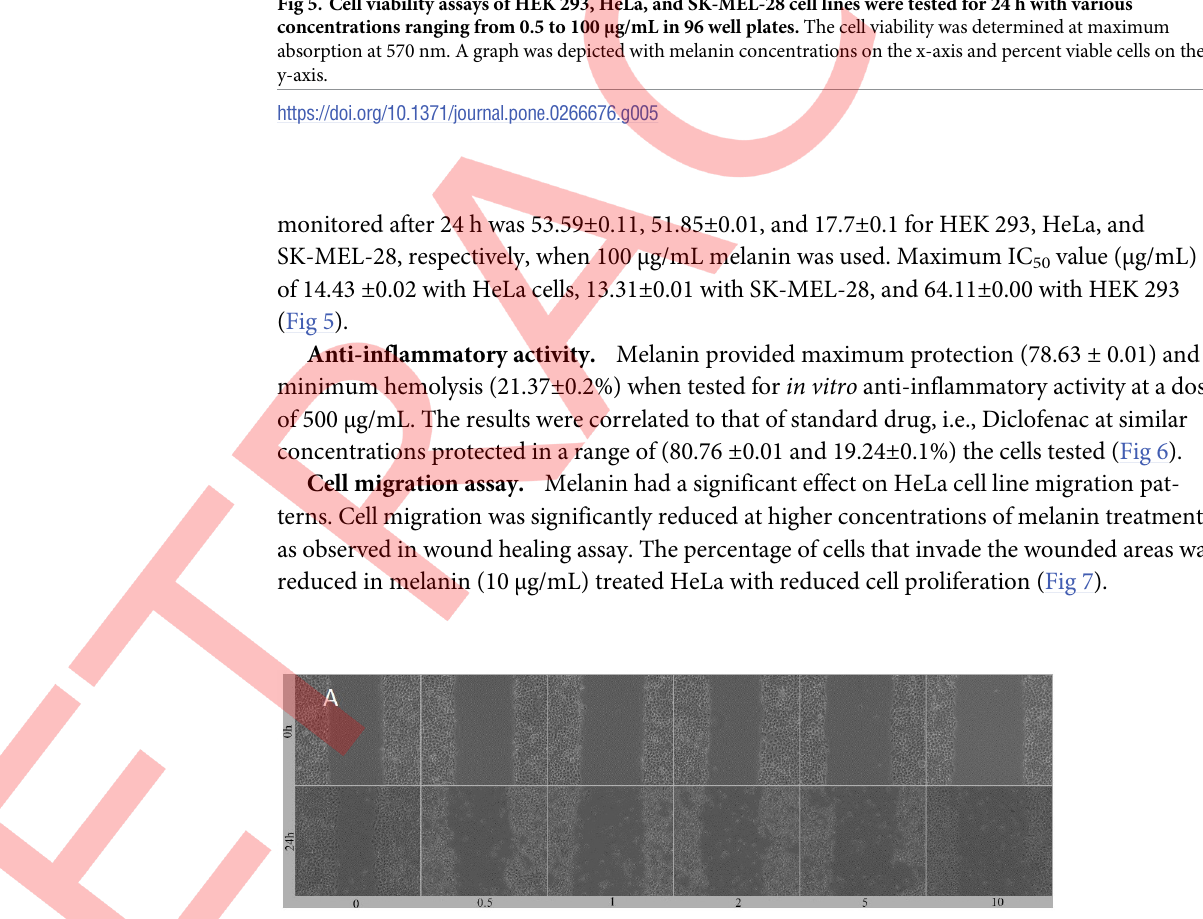
Fig 6. In-vitro wound-healing assay on HeLa cells: (0 h) wound was made by scratching a monolayer of HeLa cells with 100 μ l sterile tip and treated with indicated concentrations of melanin. To assess the degree of wound healing, cell migration towards the scratched areas was visualized and photographed at 0 h and then at 24